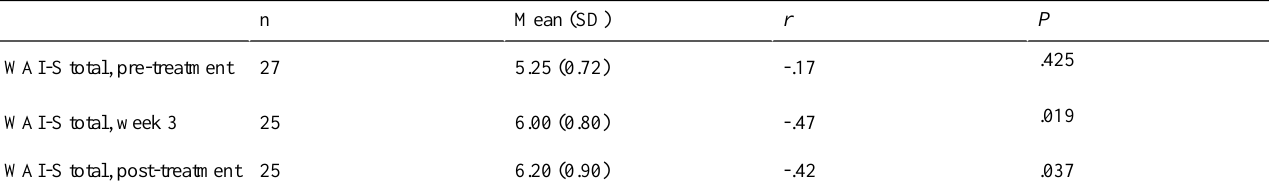
Table 1. Mean working alliance inventory short version ratings pre-, during, and post-treatment, and correlations with residualized change scores on